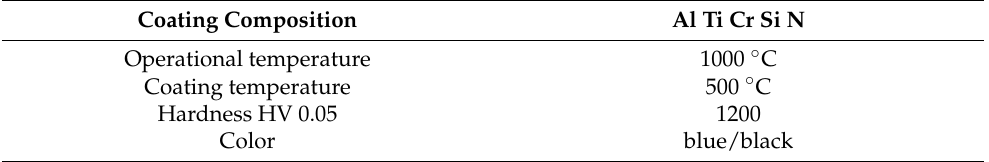
Table 2. Technical parameters of CRONAL I coating, AlTiCrSiN.